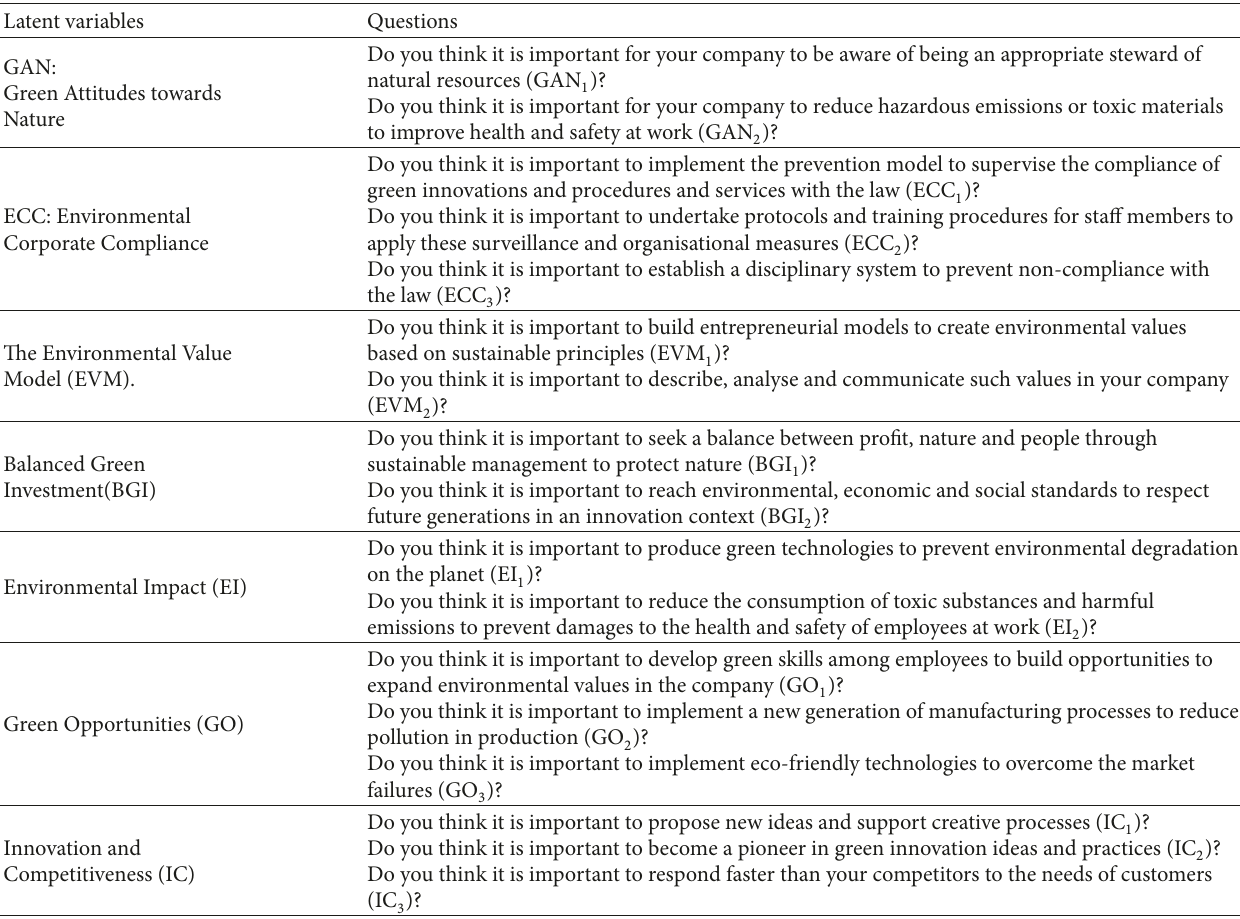
Table 2: Latent variables and the elaborated